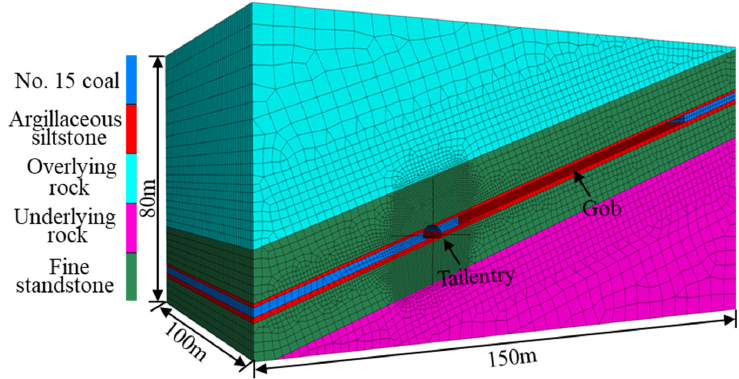
Figure 4. Numerical model for the surrounding rock of tailentry.